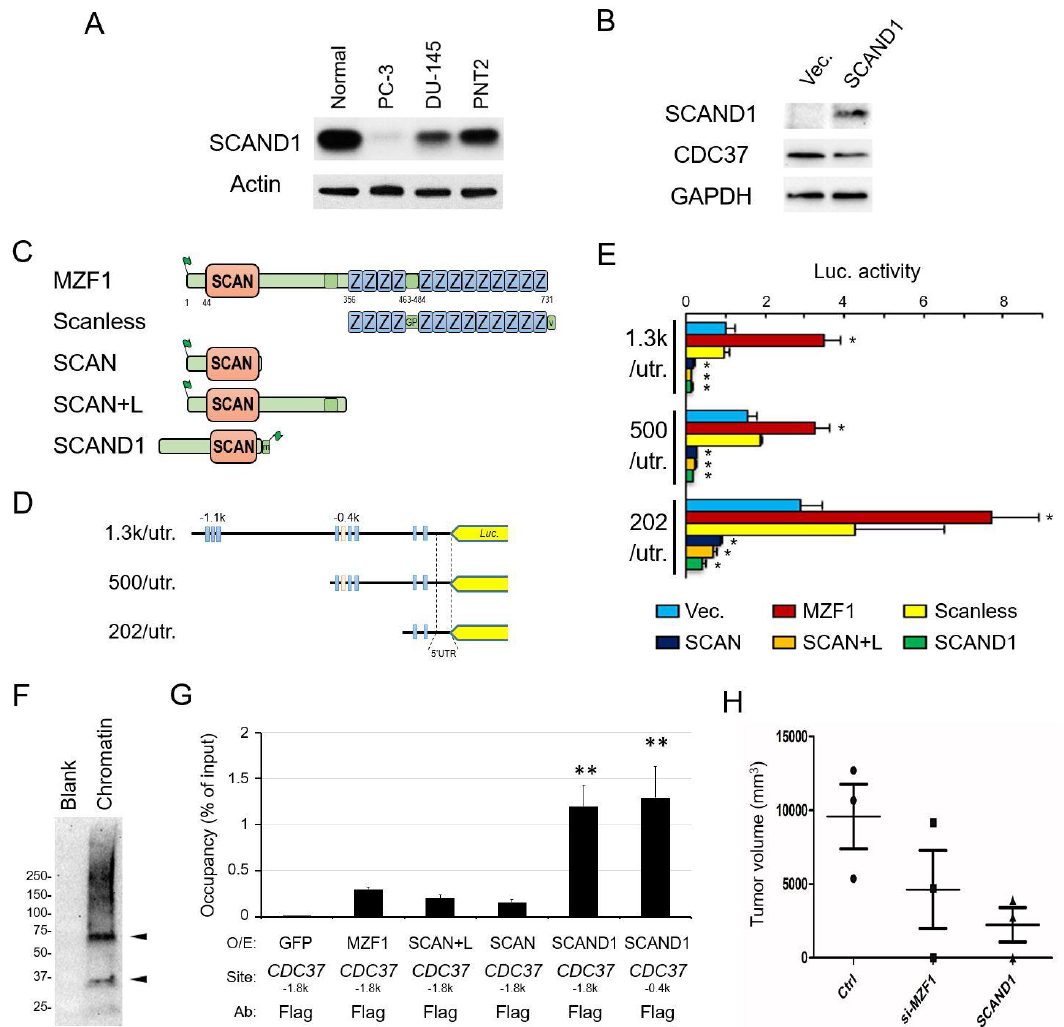
Figure 3. Zinc fingerless SCAND1 suppresses the CDC37 gene and tumorigenesis of prostate cancer. ( A ) WesternblotshowingSCAND1levelsinnormalprostatecells, PC-3, DU-145, andPNT2. ( B )